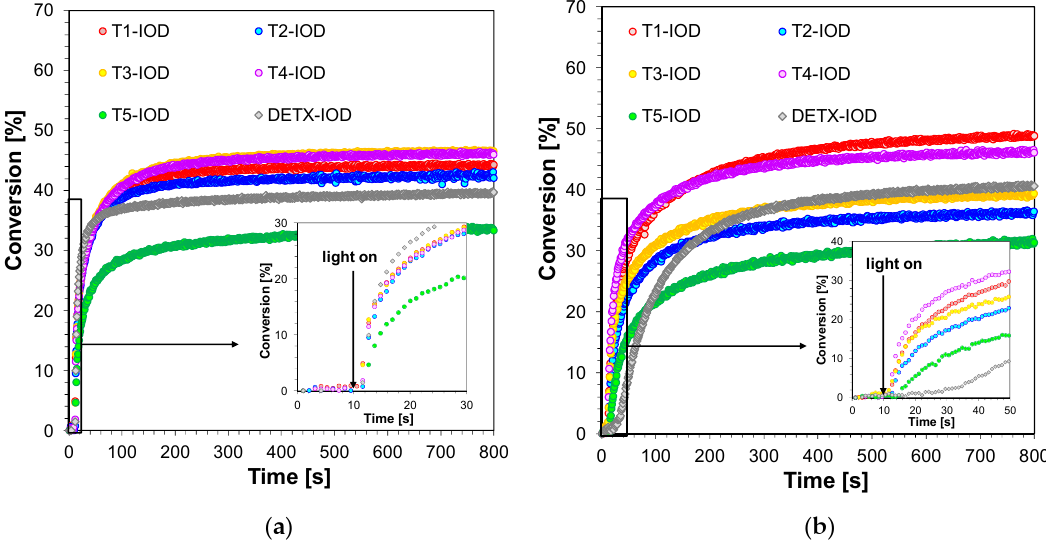
Figure 3. Photopolymerisation profiles of UVACURE ® 1500 (epoxy function conversion vs. irradiation time under air in the presence of different photoinitiating systems based on IOD (1% w / w ) and 2,4-diethyl-thioxanthen-9-one derivatives (0.2% w / w ) ) upon exposure to ( a ) the visible LED@405 nm, ( b ) the visible LED@420 nm. The irradiation starts at t = 10 s. Table 2. Functional group conversions of the epoxy monomer UVACURE ® 1500 using a photoinitiating systems based on 2,4-diethyl-thioxanthen-9-one derivatives (5.3 × 10 − 3 mol · dm − 3 , ~0.2% wt.) and bis(4- t -butylphenyl)iodonium hexafluorophosphate (IOD 1% w / w ) or